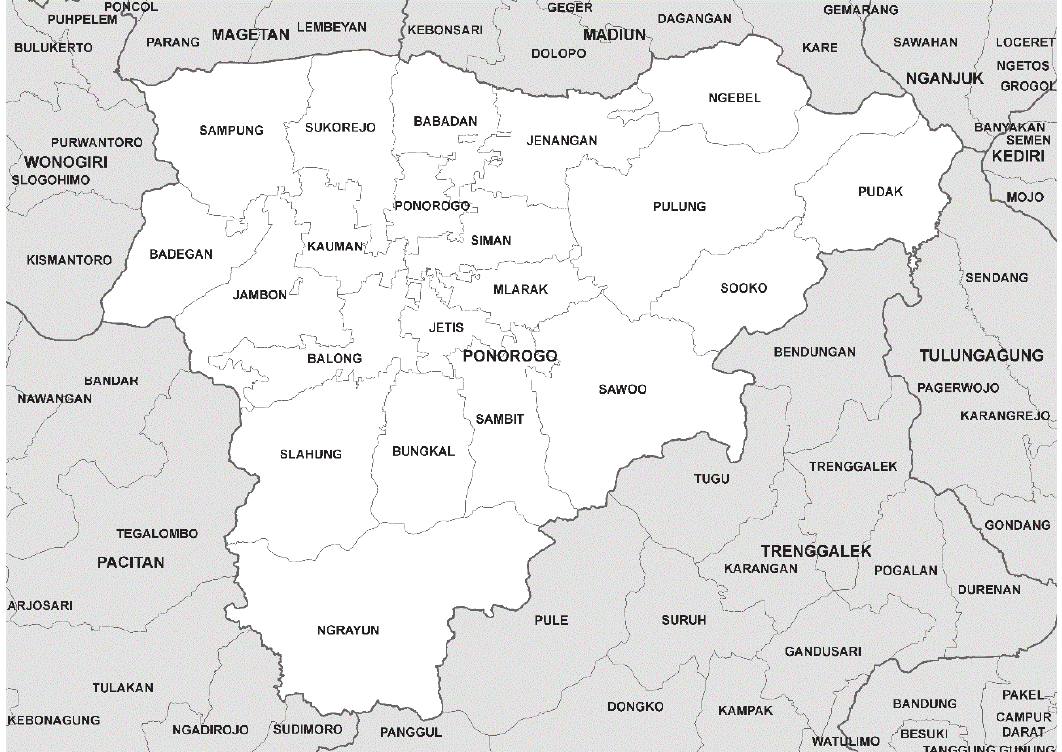
Fig. 1. Map of Ponorogo with its twenty-one